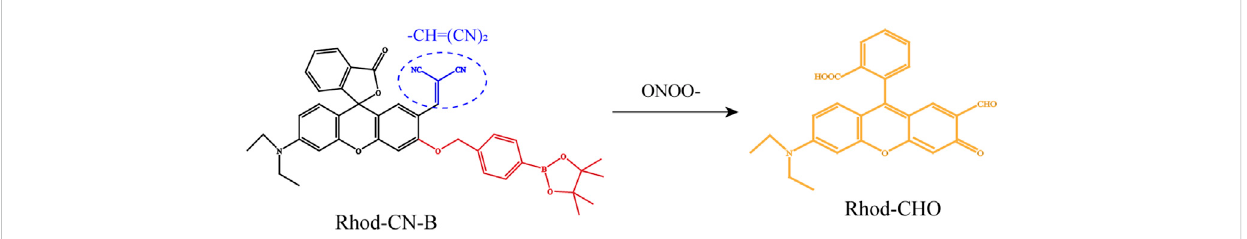
TABLE 1 Summary of optical imaging probes and their application for the oxidative stress.